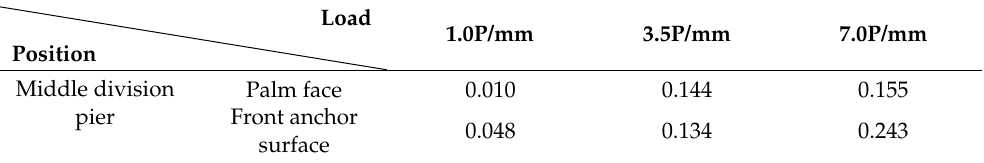
Table 1. Rheological deformation of surrounding rock of middle pier.